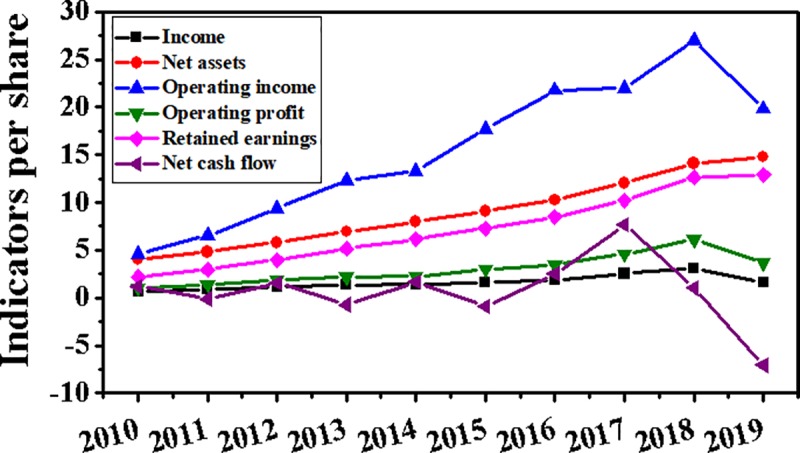
Changes in the index per share of listed company A in the past 10 years.